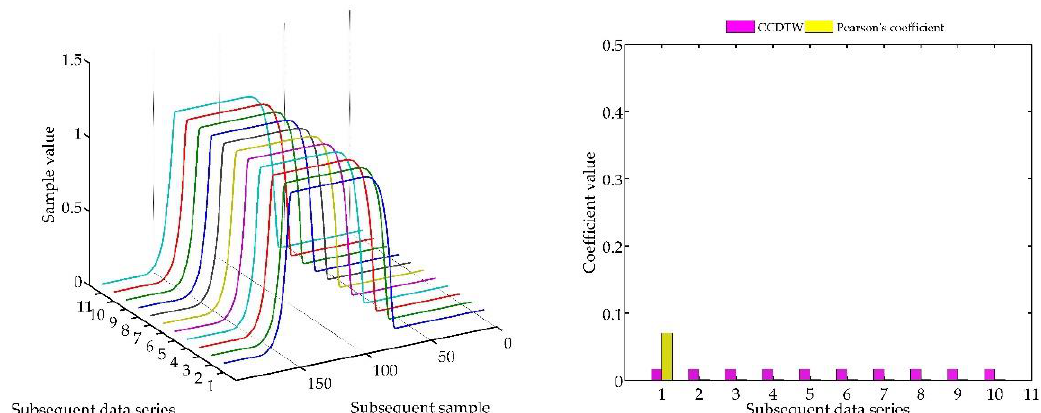
Figure 12. Simulation results achieved for data shifted by +5 samples for the first series (blue line) for r ampl = 2.